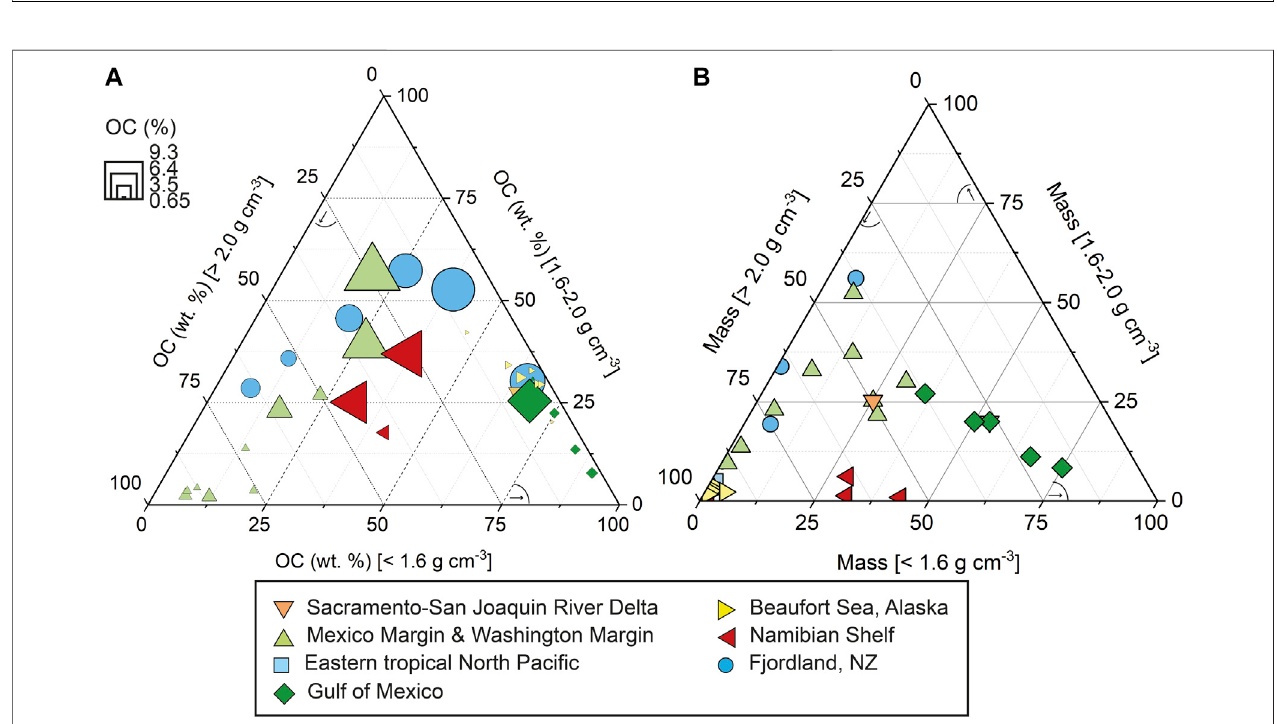
FIGURE7| CompilationofliteraturedataalongwithNamibianmargindensityfractions(thisstudy). (A) Stationsfromdifferentcontinentalmarginsplottedaccording toOC(wt%)perdensityfraction,colouredforlocation,withsymbolsizeadjustedforbulkOCcontent(%). (B) Thesamestationsplottedaccordingtomass(g)perdensity fraction,colouredforlocation.Low-densityfractionsremainimportanttotheorganiccarbonconcentrationinthebulksediment — eveninsmallquantities(Add.,Arnarson and Keil, 2001, 2007; Cui et al., 2016; Schreiner et al., 2013; Wakeham et al., 2009; Wakeham and Canuel, 2016).